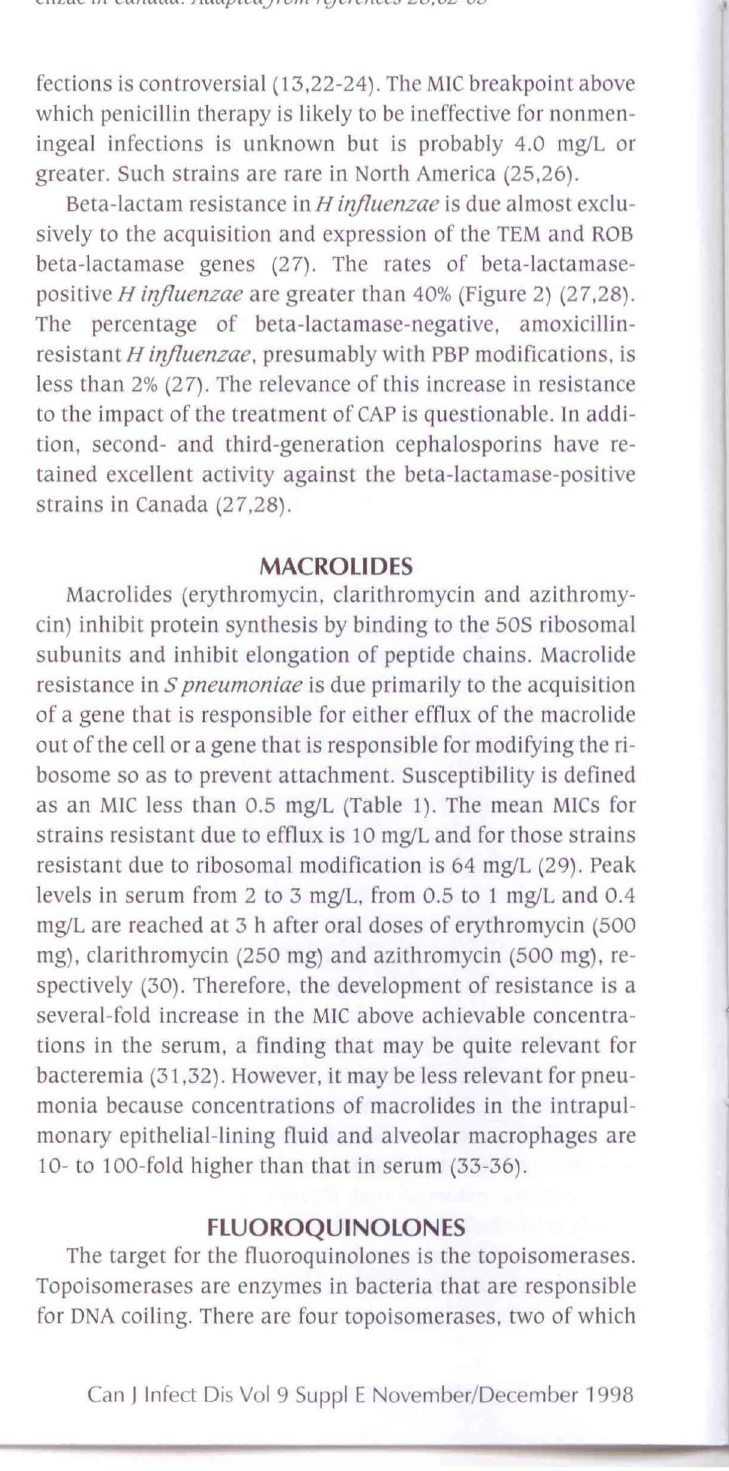
Figure 2) The evolution qfbeta-lactamase-positive Haemophilus influ enzae in Canada. AdaptedJ rom references 28,62-65